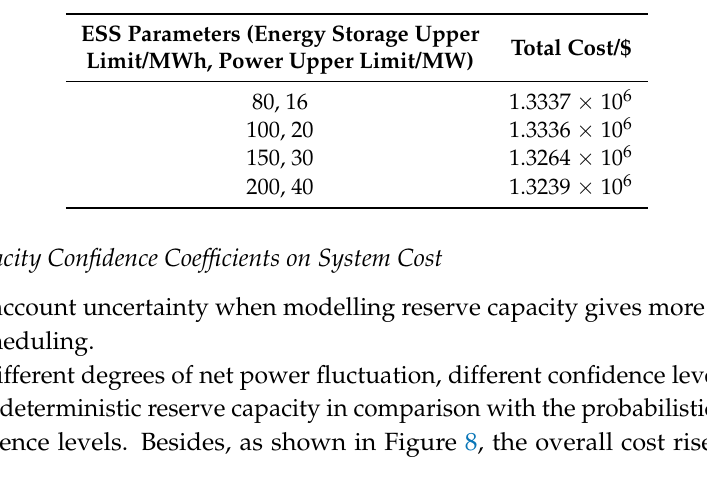
Table 3. Total cost under different ESS